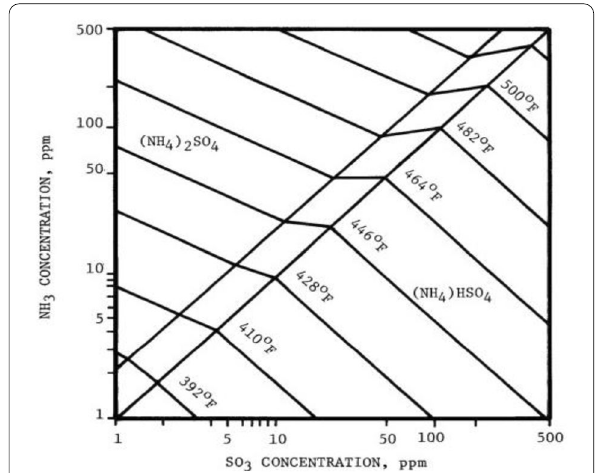
Fig. 14 Influence of NH 3 concentration on SO 3